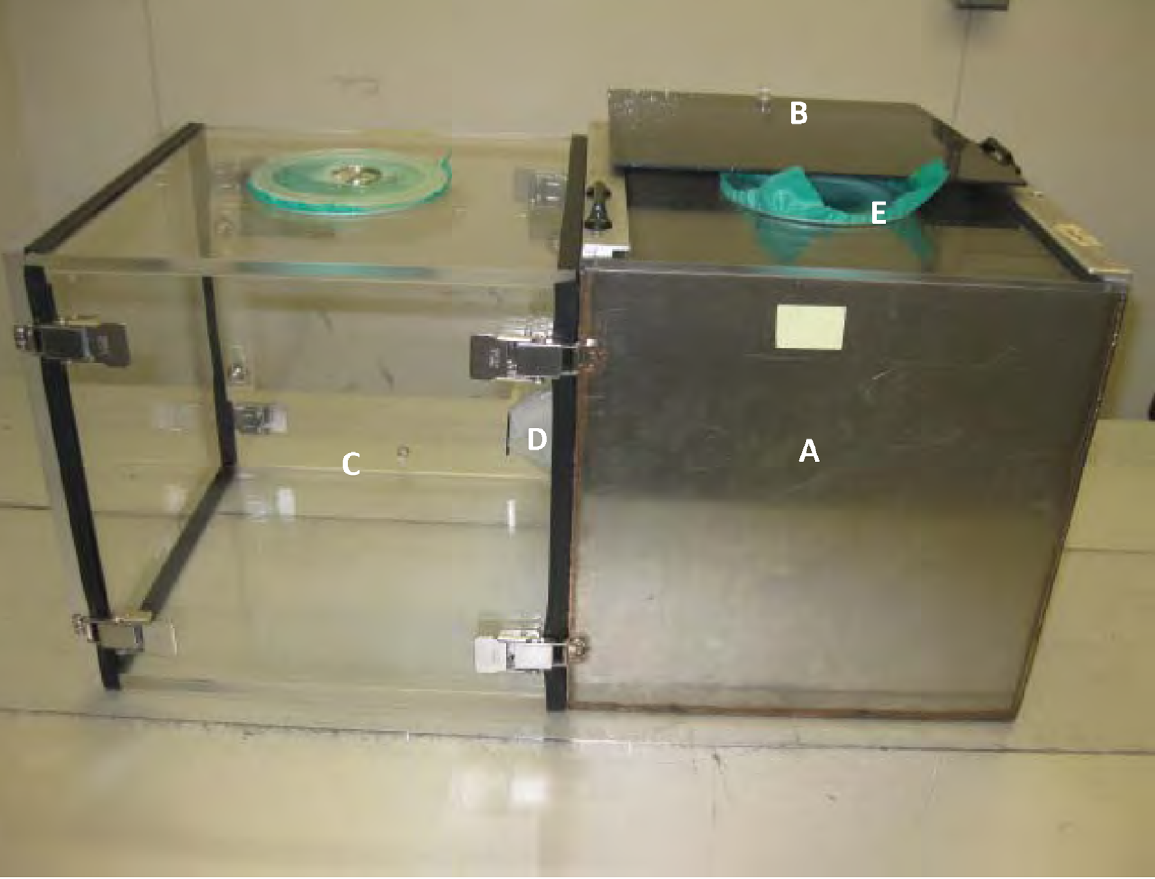
Figure 1. Laboratory assay device used to evaluate Ae.aegypti resting behavior. (A) treatment Box, (B) viewing lid, (C) Plexiglas chamber for movement evaluation, (D) funnel gate, (E) mosquito introduction/removal portal.